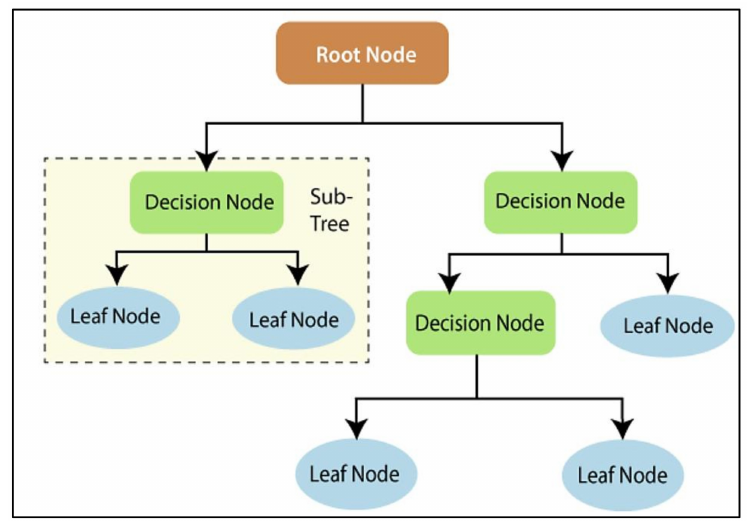
Figure 13. A sample decision